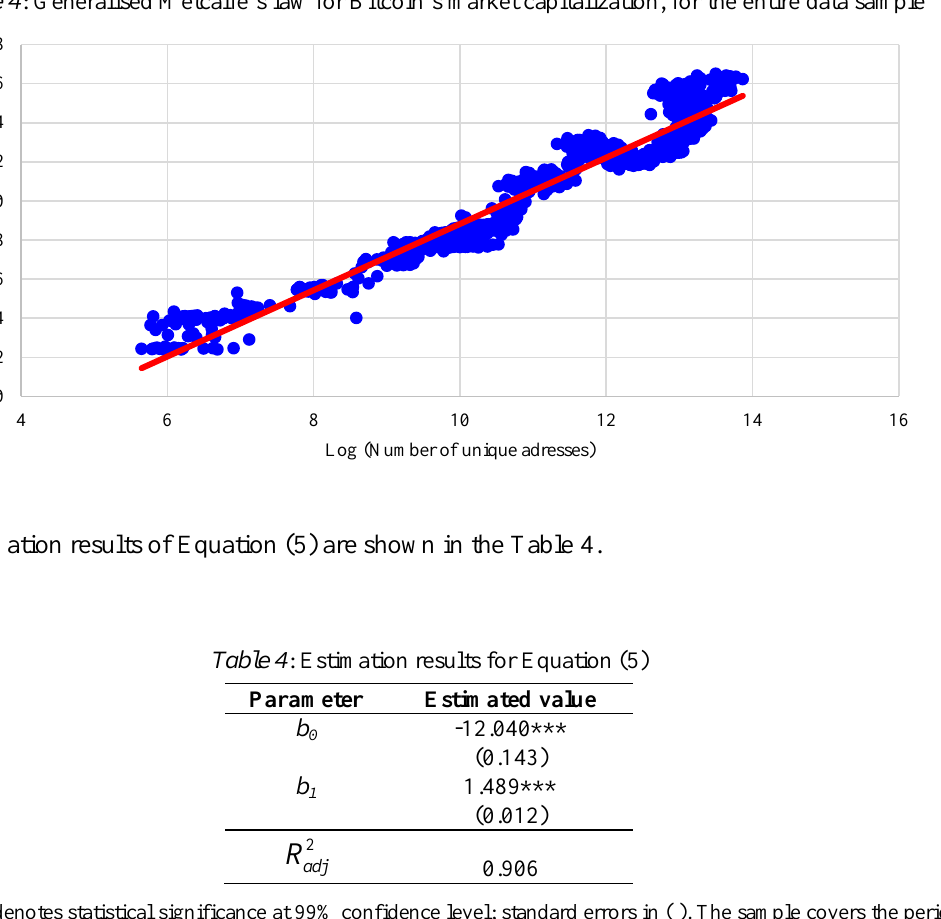
Figure 4 : Generalised Metcalfe’s law for Bitcoin’s market capitalization, for the entire data sample